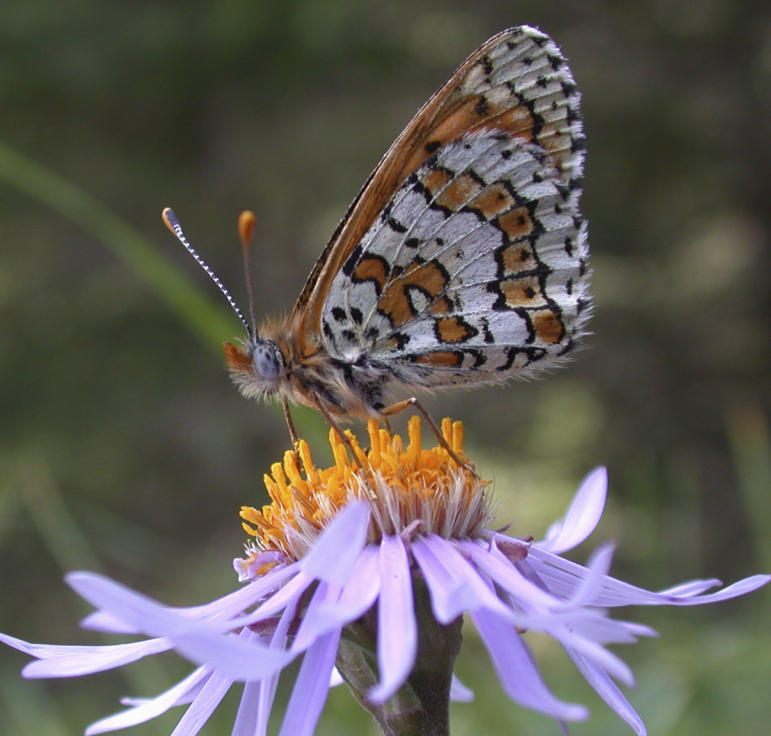
The Glanville fritillary butterfly.